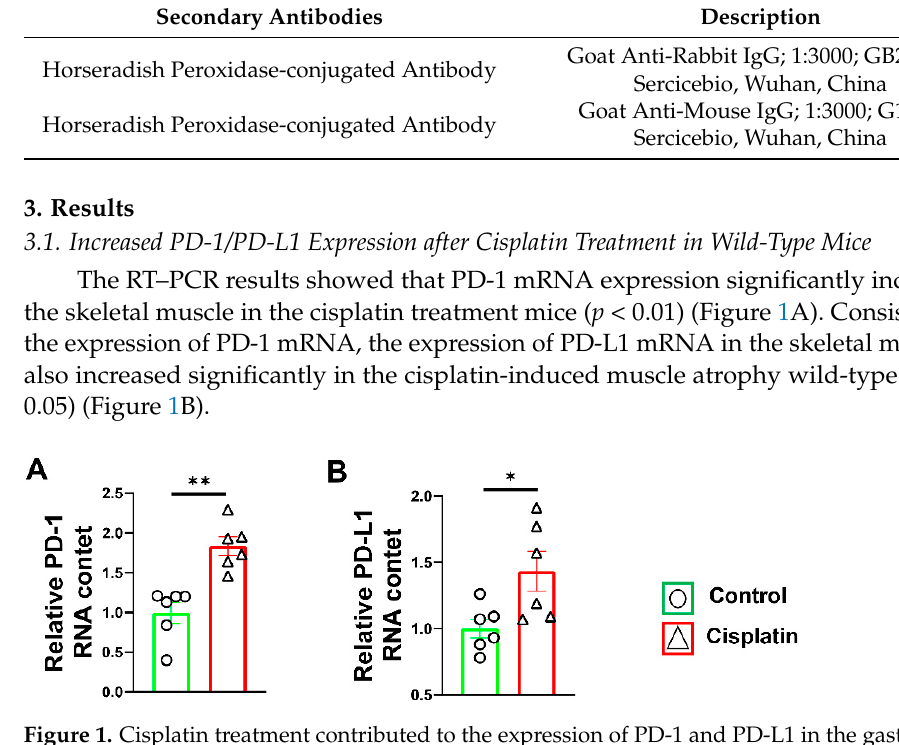
Figure 1. Cisplatin treatment contributed to the expression of PD-1 and PD-L1 in the gastrocnemius muscle. ( A ) The relative mRNA levels of PD-1 in skeletal muscle. ( B ) The relative mRNA levels of PD-L1 in skeletal muscle. mRNAs were normalized to glyceraldehyde-3-phosphate dehydrogenase (GAPDH). n = 6 per group. * p < 0.05; ** p < 0.01; all values are mean ±